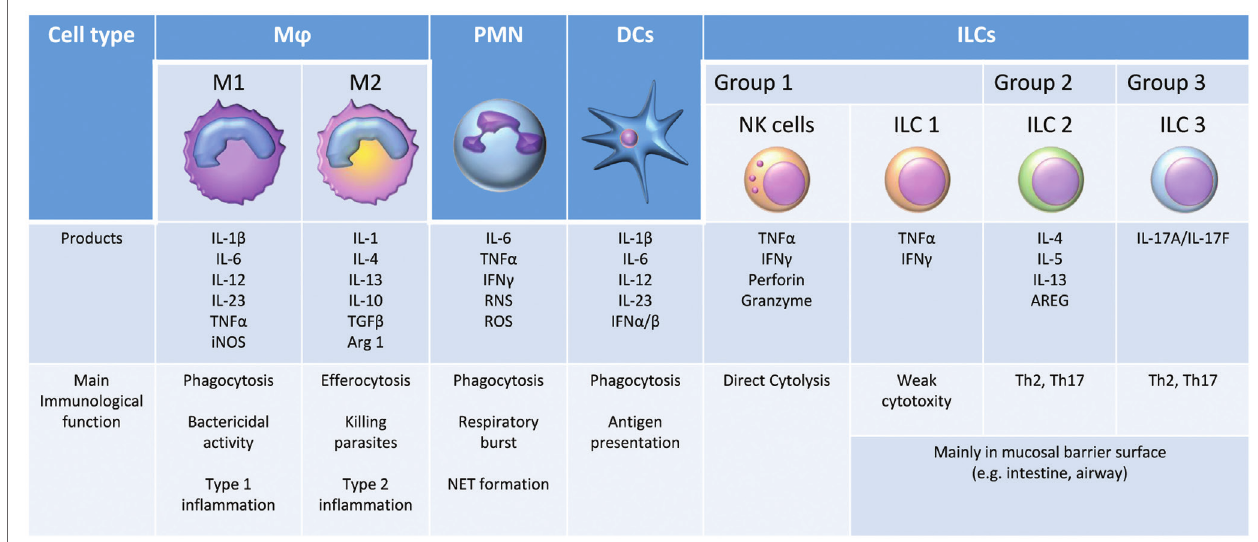
FiGURe 2 | The main immunological functions and products of innate immune